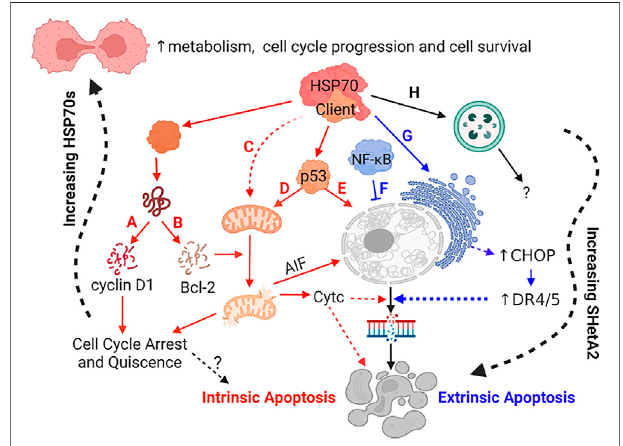
FIGURE3| MechanismsofSHetA2CounteractionofCancerPromotion by Mortalin, hsc70 and Grp78. SHetA2 counteracts the protection that mortalin, hsc70 and Grp78 give to cancer cells by disrupting their complexes with client proteins resulting in: (A) cyclin D1 phosphorylation, ubiquitination and proteasomal degradation (hypothesized to be caused by release of cyclin D1 from mortalin and hsc70) leading to reduction of Rb phosphorylation by the cyclin D1/CDK4/6 complex and G1 cell cycle arrest, (B) Bcl-2 degradation relieving Bcl-2 prevention of mitochondrial pore formation; (C) loss of mortalin functions in mitochondrial biogenesis, CA 2+ homeostasis, membrane potential and oxidative phosphorylation leading to mitochondrial damage; (D) translocation of p53 from where it is bound by mortalininthecytoplasmtothemitochondriawhereitpromotesmitochondrial pore formation; (E) translocation of p53 from where it is bound by mortalin in the cytoplasm to the nucleus where it initiates transcription of apoptosis genes; (A – E) Theevents leadto mitochondrial release ofcytochrome c (CytC) and AIF, which promote DNA and cell fragmentation leading to cell death throughintrinsicapoptosis; (F) SHetA2inhibitionofkinaseregulationofNF- κ B and its nuclear translocation and survival functions, which allows induction of extrinsic apoptosis; (G) SHetA2 induction of ER stress and UPR (hypothesized to be caused by inhibition of Grp78) leading to induction of CHOP expression, which upregulates surface DR4 and DR5 expression and sensitivitytoextrinsicapoptosis; (F – G) Mechanismsensitizingcellstoextrinsic apoptosis; (H) RolesofSHetA2-induction ofautophagyand plausibleSHetA2 effectsonCMAinthemechanismsofSHetA2-inducedapoptosisarecurrently under investigation. Solid lines: direct effects, Dashed lines: indirect effects, Yellow lines: intrinsic apoptosis, Green lines: extrinsic apoptosis; Question Marks: Active areas of investigation; Squiggly line: gradual